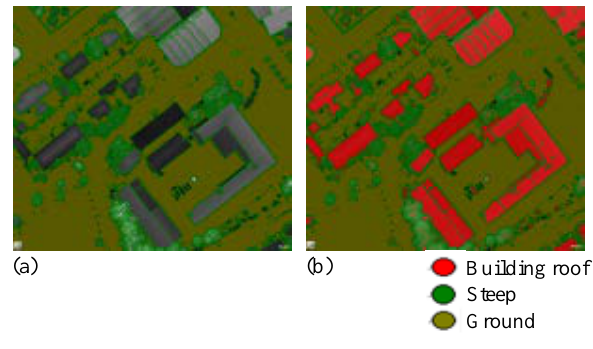
Figure 4. Classification Results